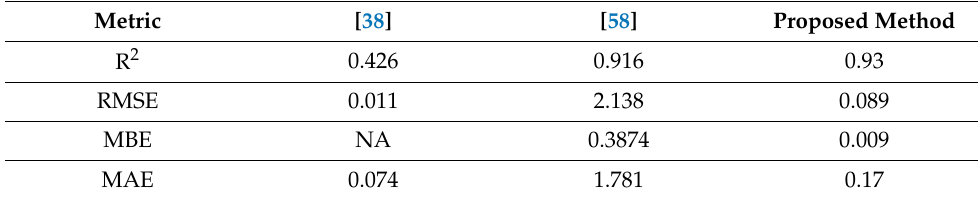
Table 7. Comparison for ANN.